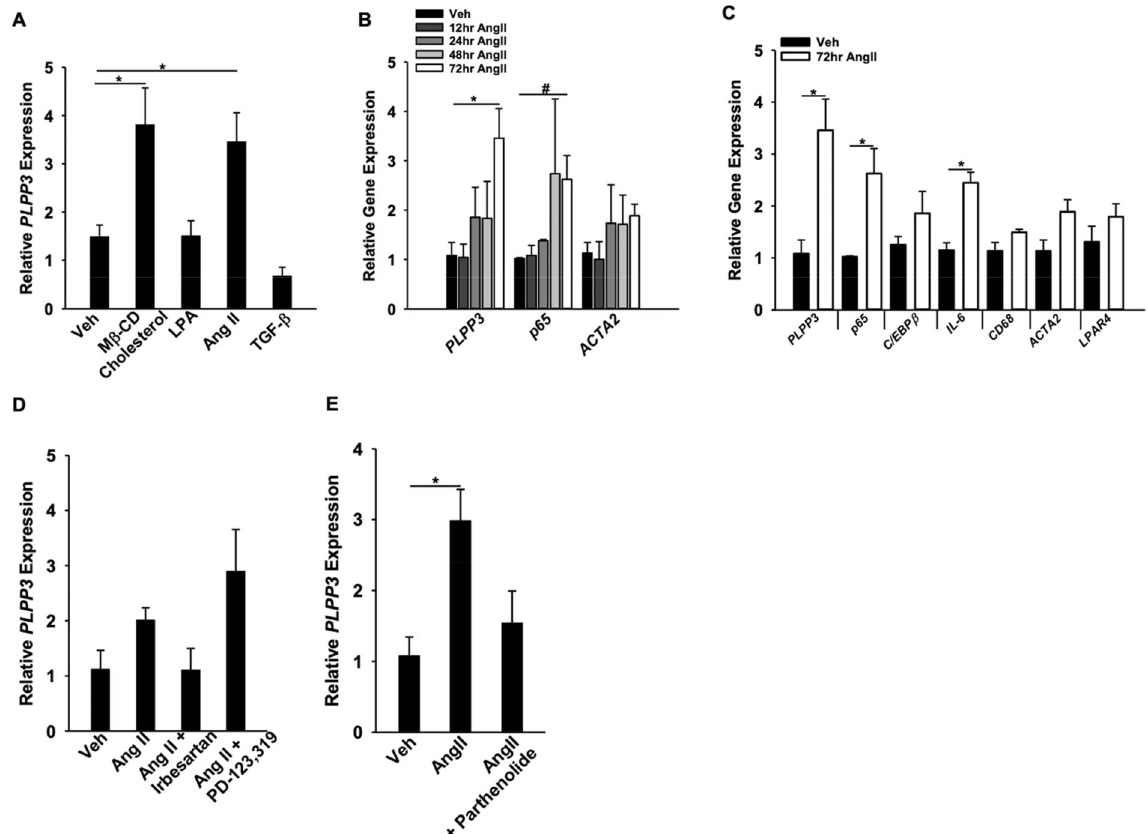
Figure 1. Regulation of PLPP3 expression by AngII and NF-κB in caHSMC. ( A ) caHSMC were treated with vehicle (n = 3), Mβ-CD Cholesterol (10 μg/ul, n = 3) LPA (1 μM, n = 3)), AngII (1 μM, n = 3), or transforming growth factor beta (TGFβ, 1 μM, n = 3) for 72 h and gene expression analyzed by qRT-PCR using 18 s as internal control. Results are presented as relative gene expression (mean ± SEM), * P < 0.05, One-way ANOVA. ( B ) caHSMCs were treated with vehicle (n = 3) or AngII (1 μM,) for 12 (n = 3), 24 (n = 3), 48 (n = 3) or 72 h (n = 6). Results are presented as relative gene expression (mean ± SEM). * P < 0.05, One-way ANOVA, # P < 0.05 Kruskal– Wallis One-way ANOVA on Ranks. ( C ) caHSMCs were treated with vehicle (n = 4) or AngII (1 μM, n = 6) for 72 h. Results are presented as relative gene expression (mean ± SEM), * P < 0.05, unpaired two-tailed student t-test. ( D ) caHSMCs were treated with vehicle, AngII (1 μM), AngII + Irbesartan (1 μM), or AngII + PD-123,319 (1 μM) for 72 h, n = 3 for all treatment conditions. Results are presented as relative PLPP3 gene expression. ( E ) caHSMCs were treated with vehicle (n = 4), angiotensin II (1 μM, n = 8) or angiotensin II + parthenolide (1 μM, n = 3) for 72 h. Results are presented as relative gene expression (mean ± SEM) * P < 0.05, One-way